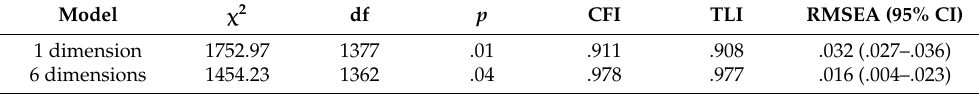
Table 3. The goodness of fit indices for testing dimensionality of inductive reasoning